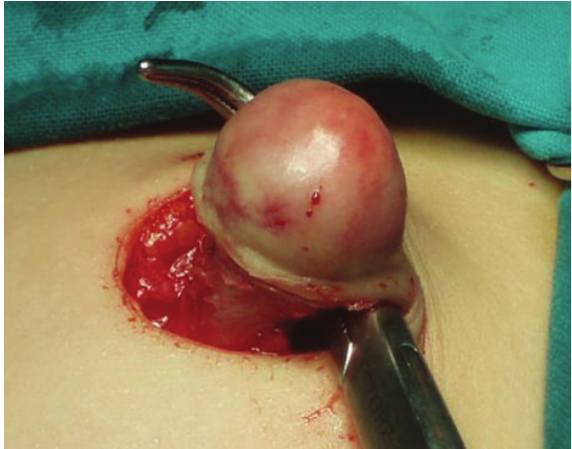
Figure 4: Operative picture showing the sac containing the strangulated and congested